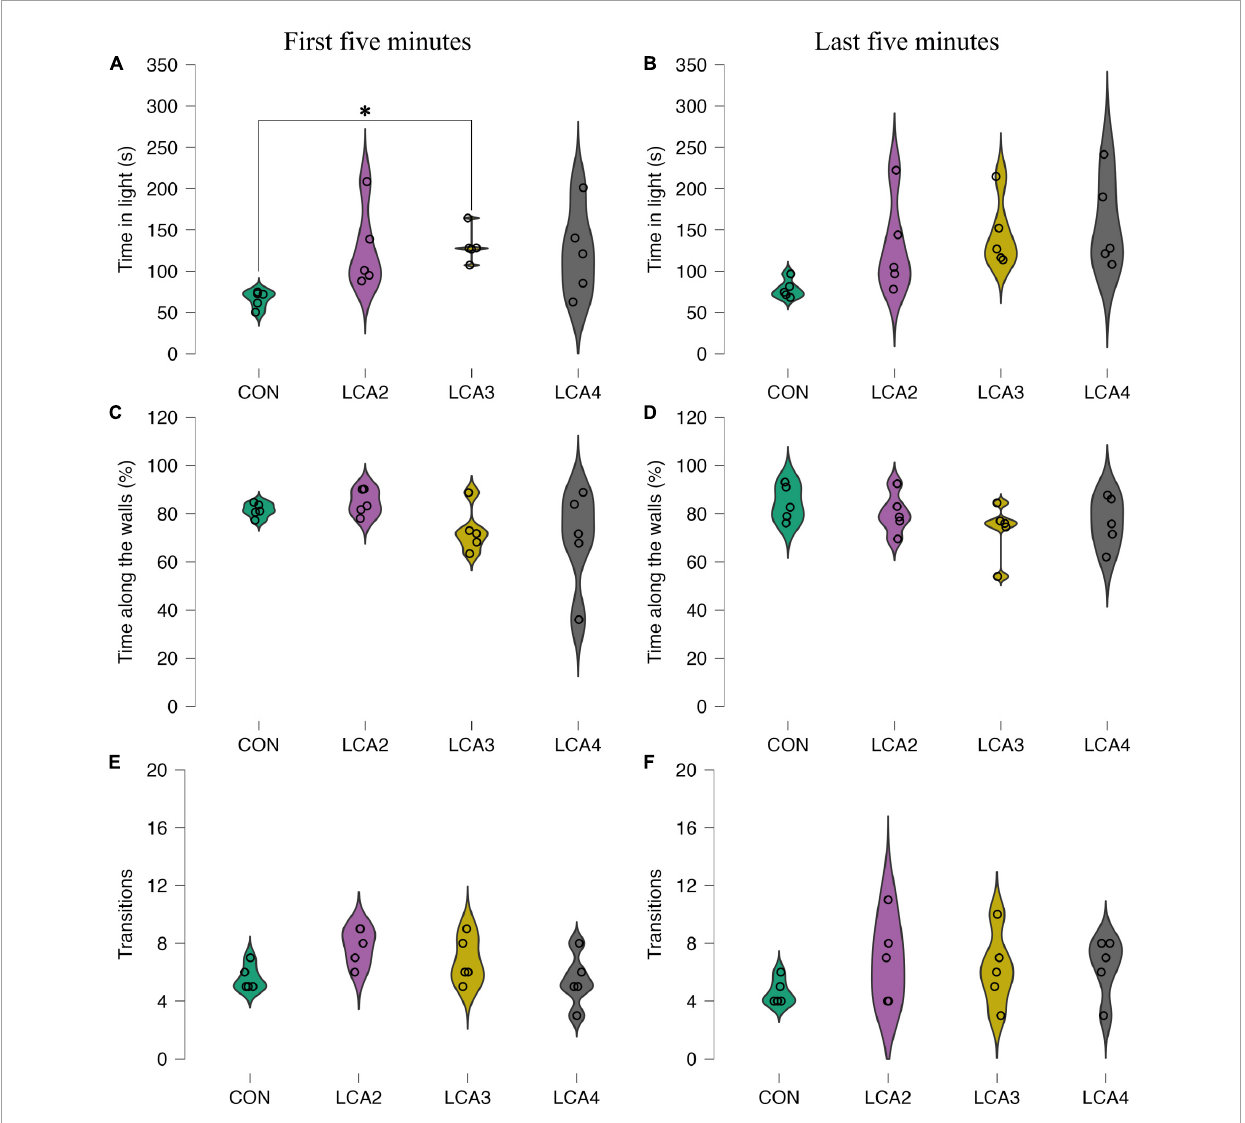
FIGURE3 LDB test anxiolytic parameters with individual observations and smoothed distribution curves for each group segregated into the first 5 min and last 5 min. (A,B) The time spent in the light compartment for each group. In general, the LCA groups spent more time in the light compartment compared to the CON. A statistically significant difference was found between the CON and LCA3 during the first 5 min. (A) Group means: CON = 66 s [95% CI (57, 75)], LCA2 = 126 s [95% CI (83, 170)], LCA3 = 131 s [95% CI (113, 149)], LCA4 = 122 s [95% CI (75, 169)]. (B ) The estimated group means: CON = 79 s [95% CI (67, 88)], LCA2 = 129 s [95% CI (79, 179)], LCA3 = 145 s [95% CI (108, 181)], LCA4 = 158 s [95% CI (108, 207)]. (C,D) The percentage of total time in the light compartment spent along the walls. (C) Group means: CON = 81% [95% CI (79, 84)], LCA2 = 85% [95% CI (80, 89)], LCA3 = 73% [95% CI (65, 81)], LCA4 = 70% [95% CI (51, 88)]. (D) Group means: CON = 84% [95% CI (78, 91)], LCA2 = 80% [95% CI (87, 73)], LCA3 = 73% [95% CI (63, 83)], and LCA4 = 77% [95% CI (67, 86)]. (E,F) Number of transitions from light to dark compartment. (E) Group